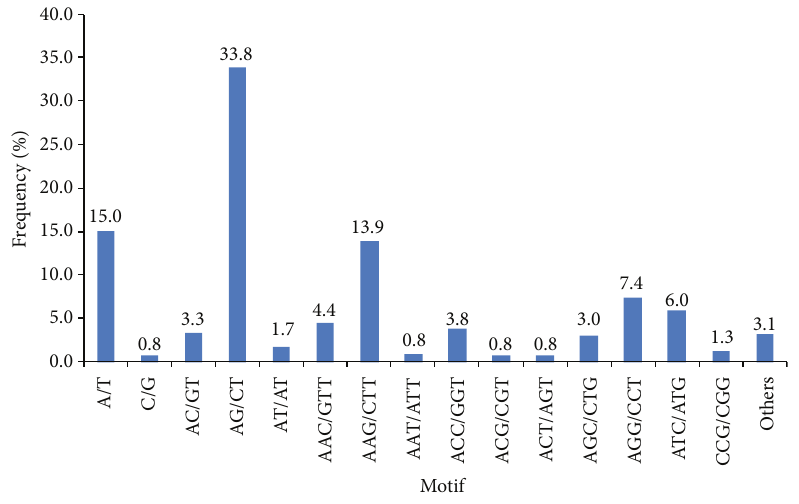
Figure 3: Frequency distribution of EST-SSRs according to motif sequence